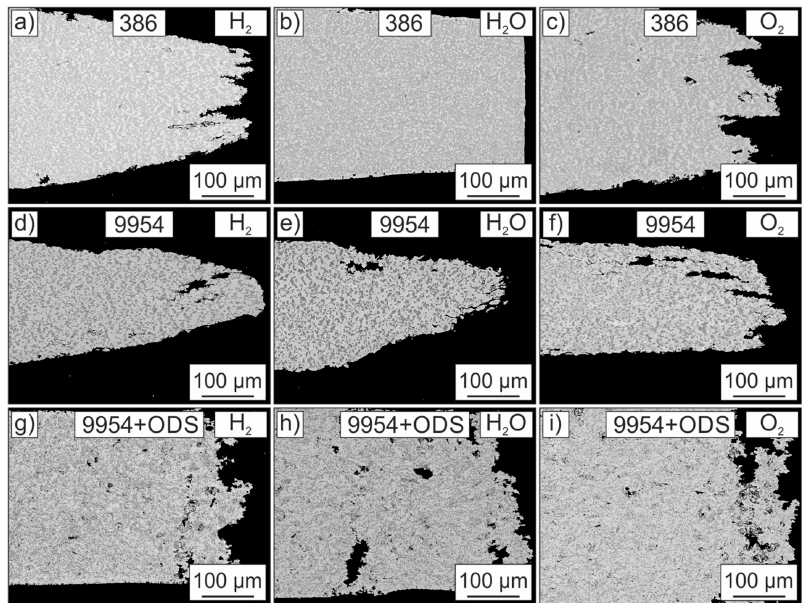
Figure 6. BSE images of the microstructures of Amdry 386 ( a – c ), Amdry 9954 ( d – f ) and Amdry 9954 + ODS ( g – i ) after tensile creep tests at 900 °C. Before creep testing, the samples were heat + ODS ( g – i ) after tensile creep tests at 900 ◦ C. Before creep testing, the samples were heat treated in treated in Argon with the additions of 4% H 2 + 2% H 2 O, 2% H 2 O and 20% O 2 . Argon with the additions of 4% H 2 + 2% H 2 O, 2% H 2 O and 20% O 2 Based on the strong ODS effect of the Al 2 O 3 particles, the ODS-containing bond coats failed much earlier than Amdry 9954, resulting in a more furrowed fracture surface.